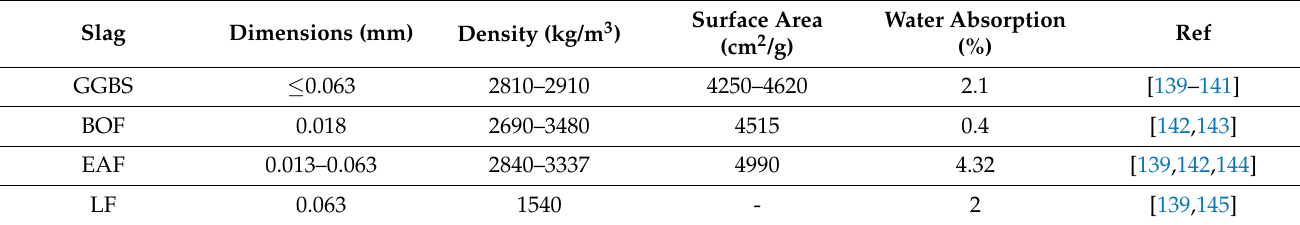
Table 10. Physical properties of different metal slags.